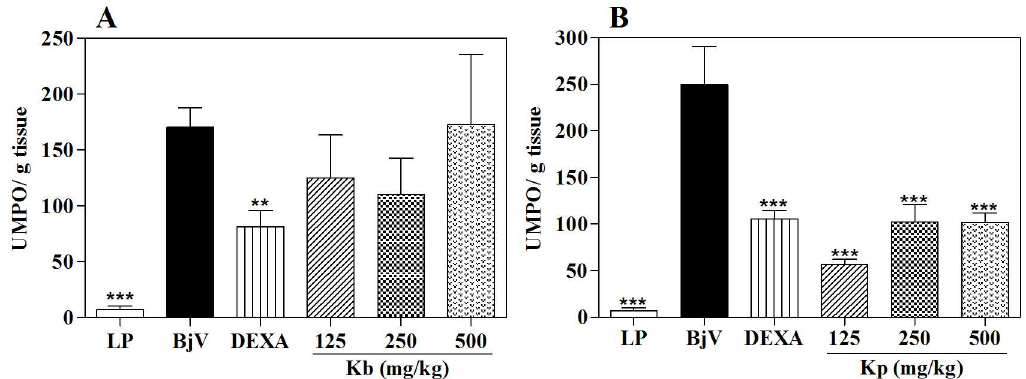
Fig 5. Inhibition of B . jararaca (BjV) venom-induced hemoglobin accumulation by extracts of K . brasiliensis (Kb) (A) and K . pinnata (Kp) (B) in post-treatment protocol. The percentage of activity presented was calculated as: [(Hemoglobin content in animalsreceivingvenom plus extract (cid:4) Hemoglobincontent in animalsreceivingvenom alone)x 100]. Values expressedas mean ± SEM (n = 5). * p < 0.05and *** p < 0.001comparedto venom alone (BjV) (100% of activity) (one-way ANOVA followedby the Tukey’s